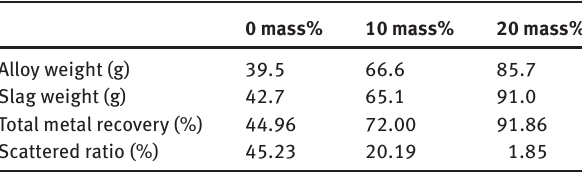
Table 3: Effect of different Al 2 O 3 additions on weight of products, total metal recoveries and scattered ratios of SHS reactions for estimated composition of 10Al-40Co-50Ni mass% (RUN2)